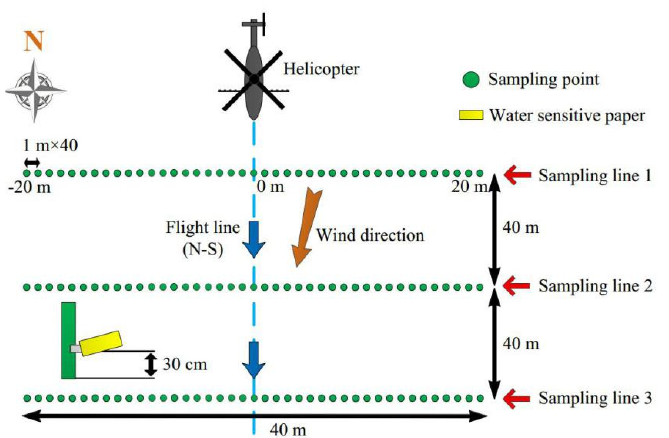
Figure 5. Schematic diagram of field test.